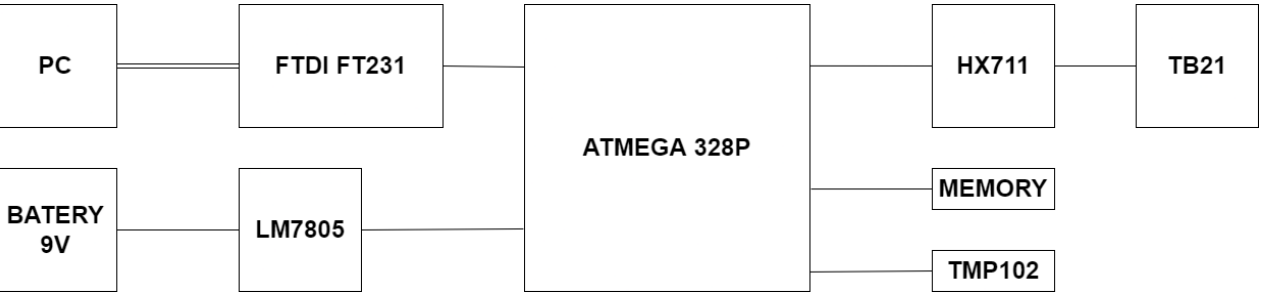
Figure 6. Schematic of force-transducer components.